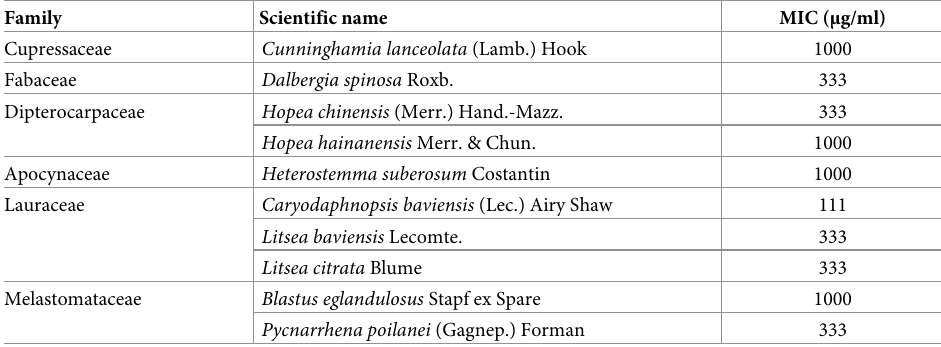
Table 1. Minimum inhibitory concentrations (MICs) of the methanol extracts from the leaf and stem extracts of Vietnamese plants against Alternaria porri .